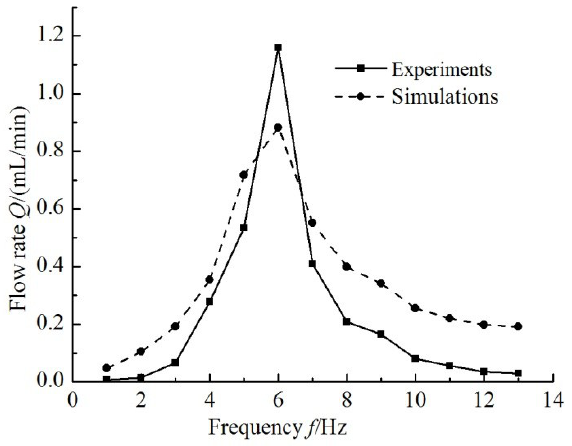
Figure 12. Comparison of experimental flow rate with simulation flow rate.